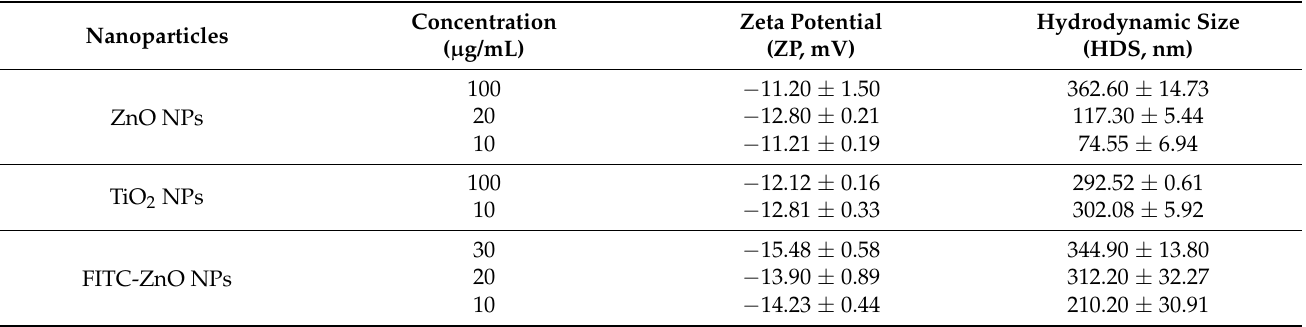
Figure 1. Characterization of ZnO NPs and TiO 2 NPs. ( A – C ) The representative morphologies of ZnO NPs shown using cryogenic transmission electron microscopy (Cryo-TEM) ( A ), the crystal struc- ture of ZnO NPs analyzed using selected area electron diffraction (SAED) ( B ), and size-distribution histograms of ZnO NPs obtained using Nano Measurer software ( C ). ( D – F ) The representative mor- phologies of TiO 2 NPs shown using Cryo-TEM ( D ), the crystal structure of TiO 2 NPs analyzed using SAED ( E ), and size-distribution histograms of TiO 2 NPs obtained using Nano Measurer software ( F ). ( G – I ) The representative morphologies of FITC-ZnO NPs shown using cryogenic transmission elec- tron microscopy (Cryo-TEM) ( G ), the crystal structure of FITC-ZnO NPs analyzed using selected area electron diffraction (SAED) ( H ), and size-distribution histograms of FITC-ZnO NPs obtained using Nano Measurer software ( I ). Cryo-TEM scale bar = 100 nm, SAED scale bar = 5.00 1/nm, counts include more than 300 particles in each case of size analysis. Table 1. The hydrodynamic diameter and zeta potential of ZnO and TiO 2 NPs in DMEM high sugar medium with 10%